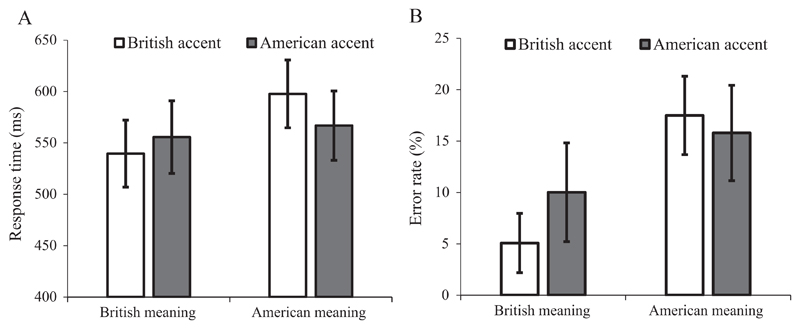
Response times (A) and error rates (B) in Experiment 5. Error bars show ±1 SE, adjusted to show within-participant effects of meaning (Morey, 2008).